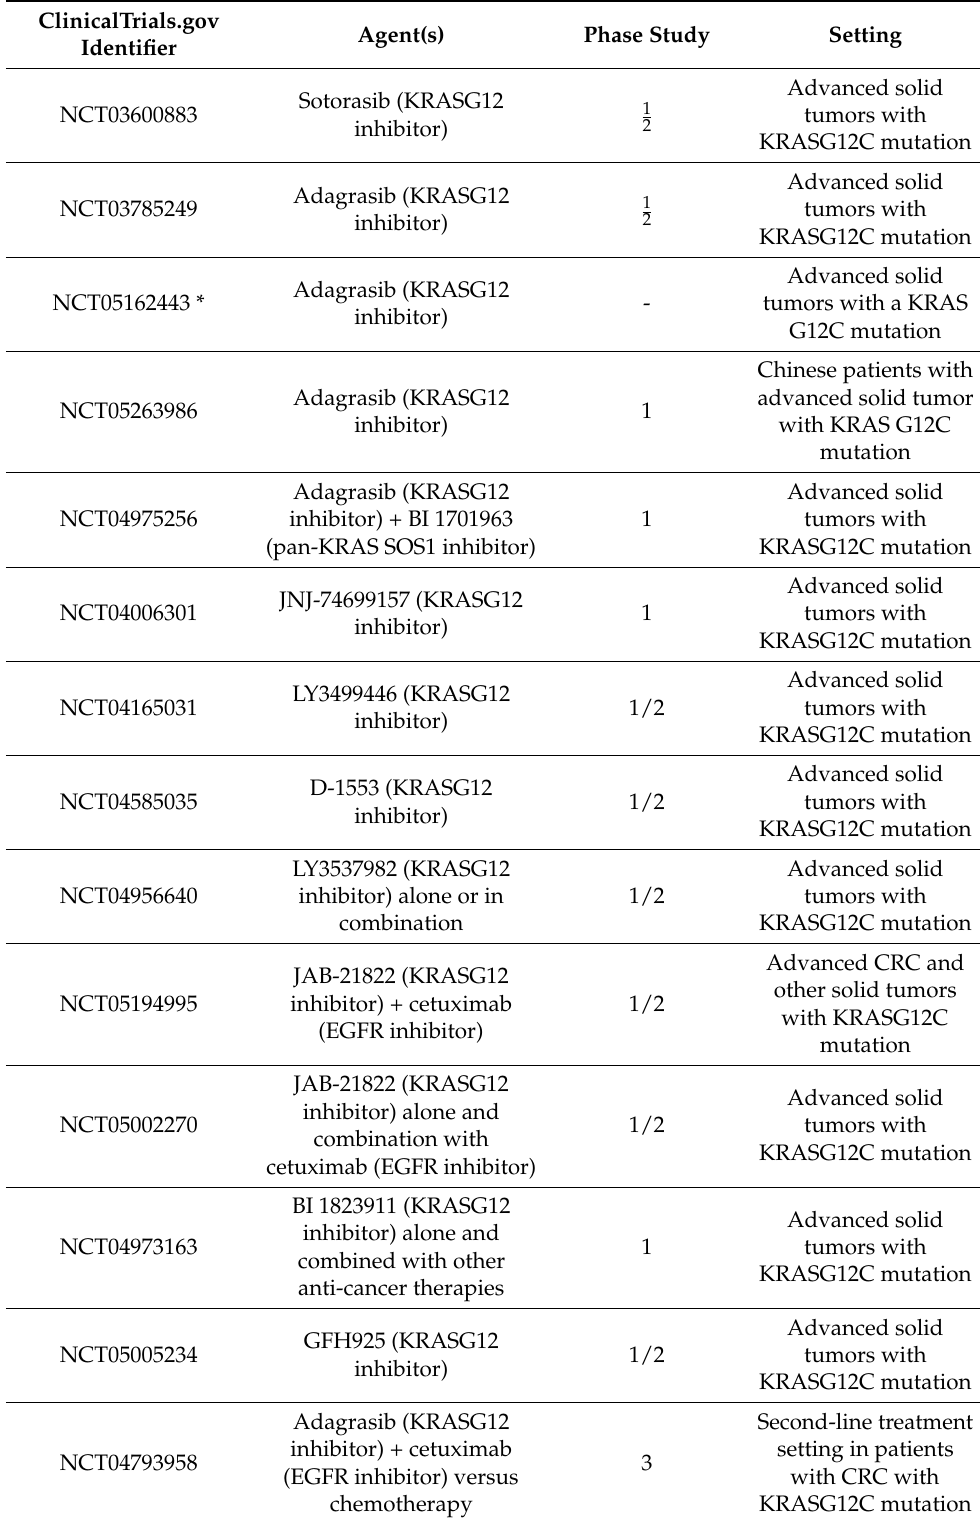
Table 1. A selection of clinical trials with KRAS, SHP2 and SOS1 inhibitors registered on ClinicalTrials. gov, accessed on 6 March